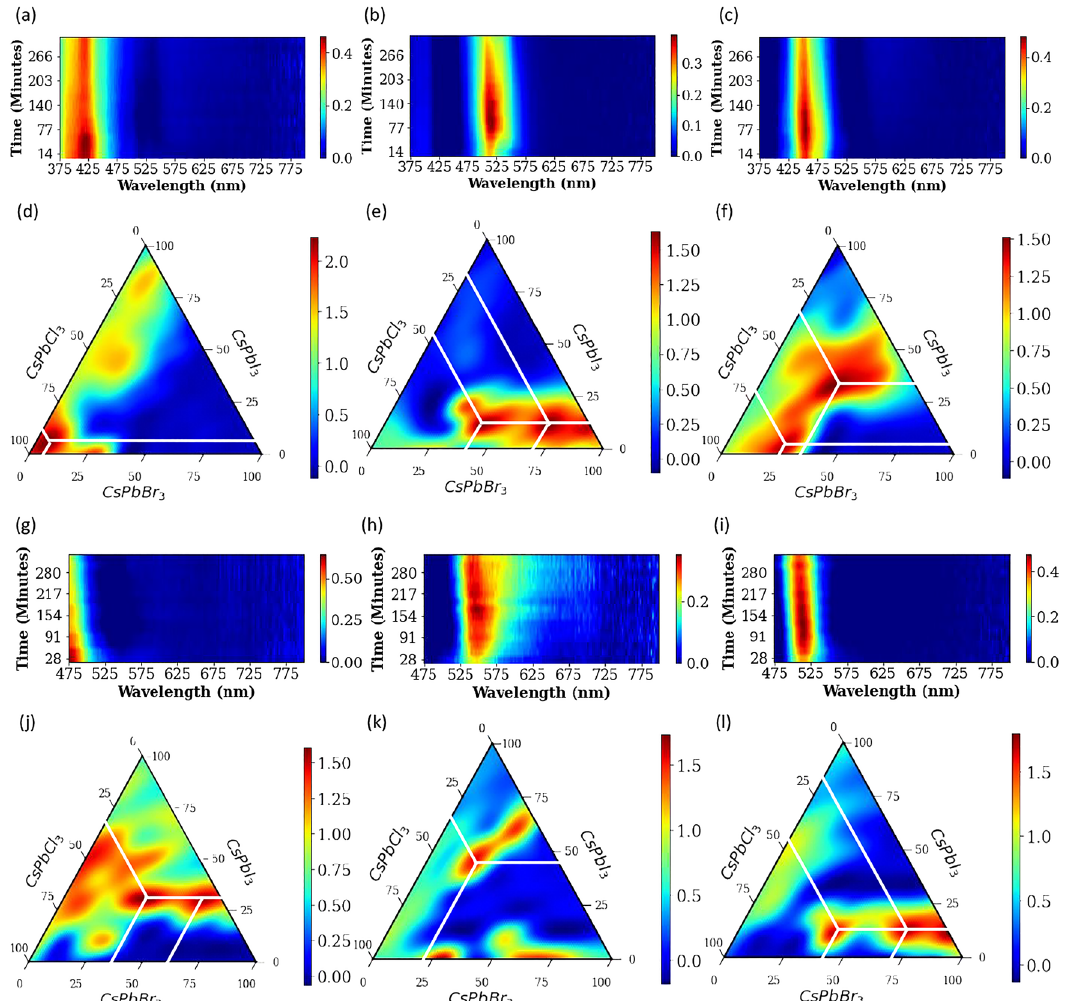
Figure 2: The multivariate analysis of time-dependent PL properties of ternary CsPb(I x Br y Cl 1 − x − y ) 3 QDs system. At an excitation of 350 nm, 2D non-negativematrixfactorization(NMF)componentsofPLbehaviorofthecorrespondingphasediagram(representedbyanonzeroweight)as a function of wavelength and time where the color describes the intensity of the PL peak (top: (a) – (c)) and Gaussian processing (GP) interpolation of compositional dependencies of the component PL intensities within the ternary diagram where the color is indicative of how thecharacteristicPLbehaviorovertimedescribesthatcompositionalregion(bottom:(d) – (f)).Atanexcitationof450nm,2DNMFcomponents (top: (g) – (i)) and compositional dependencies of the component intensities within the ternary diagram (bottom: (j) –